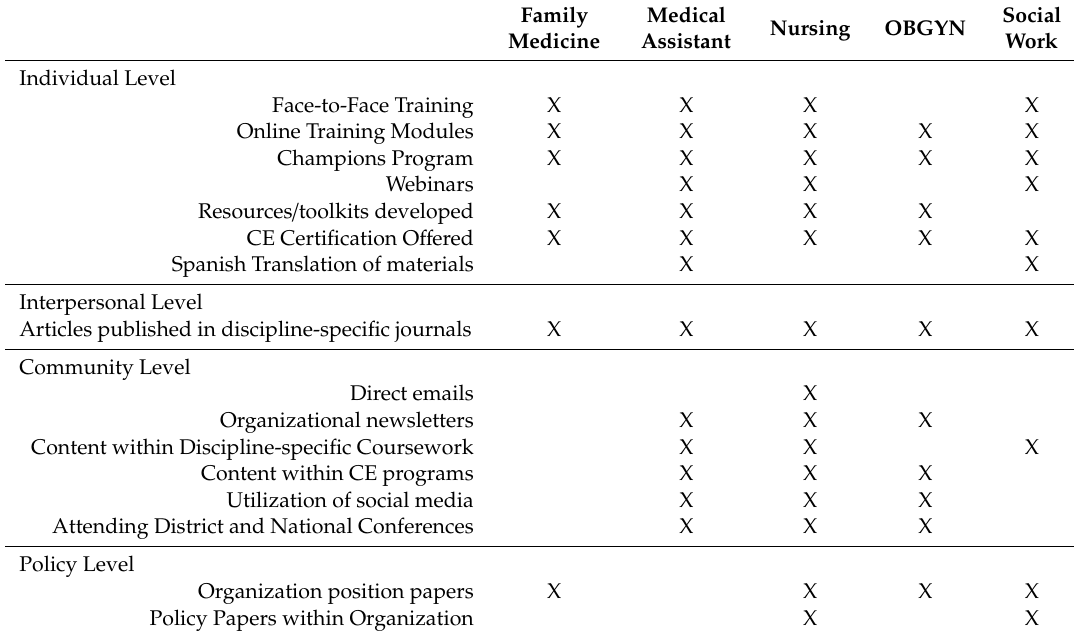
Table 1. Alcohol Exposed Pregnancy Prevention Strategies by Social Ecological Model Domains and Discipline.